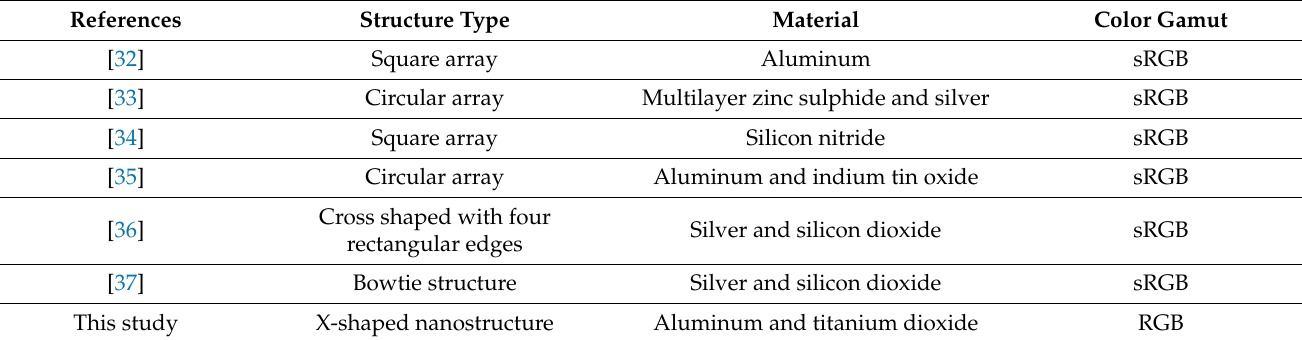
Table 2. Comparison with other recently reported plasmonic color